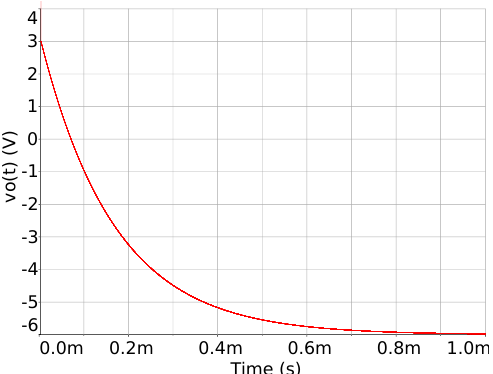
Figure 7. Simulation result of the transient response of the RL circuit using L = 1